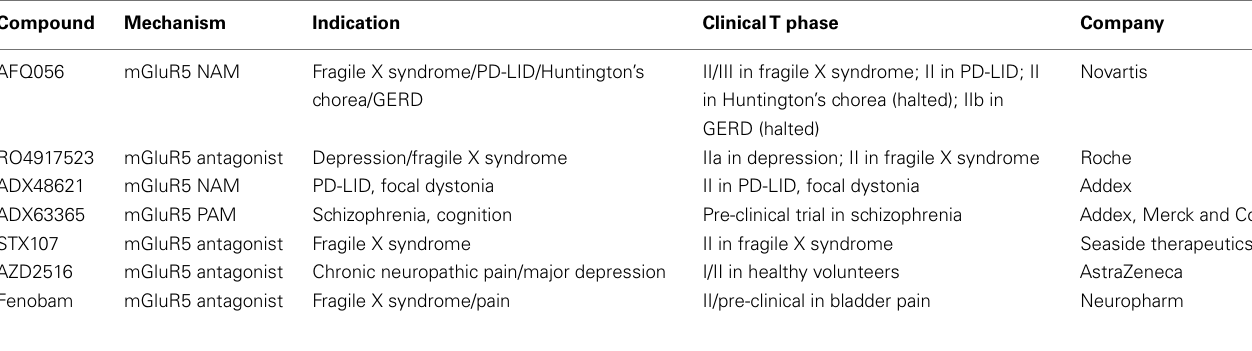
Table 1 | mGluR5 modulators in clinical